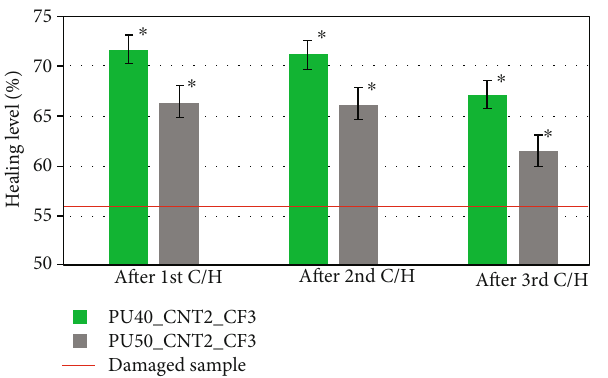
Figure 9: Comparison of the healing level of nanocomposites after the fi rst C/H cycles ( ∗ ) denotes a statistically signi fi cant di ff erence between damaged samples and after healing ( p < 0 : 05